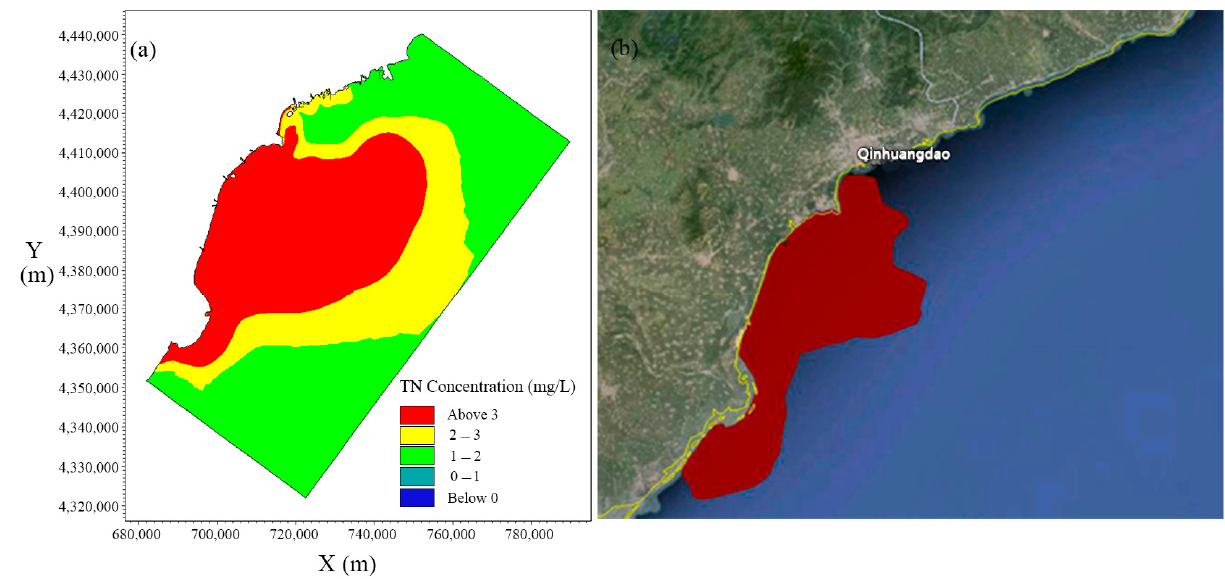
Figure 6. ( a ) The distribution of TN concentration during the brown tide period in May 2014. ( b ) The satellite-observed brown tide area in May 2014.